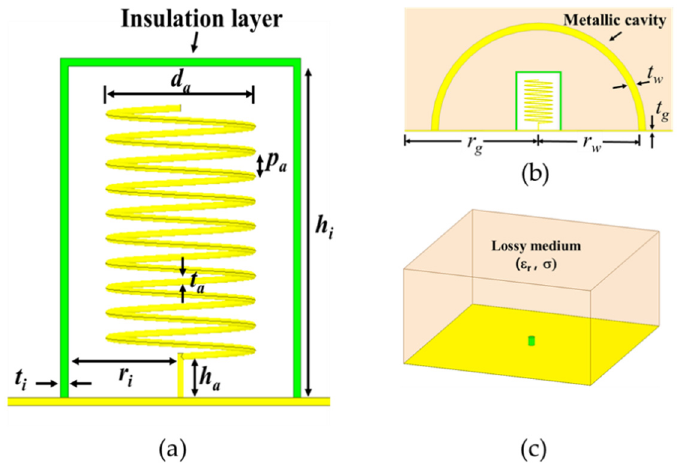
Figure 4. Geometry of simulation setup: ( a ) cross-sectional view of NMHA and ( b ) with metallic cavity, ( c ) perspective view. ( d a = 20, p a = 3, h a = 6.4, t a = 0.8, r i = 15, h i = 40, t i = 1, r g = 500, t g = 1, t w = 5. Unit: mm.